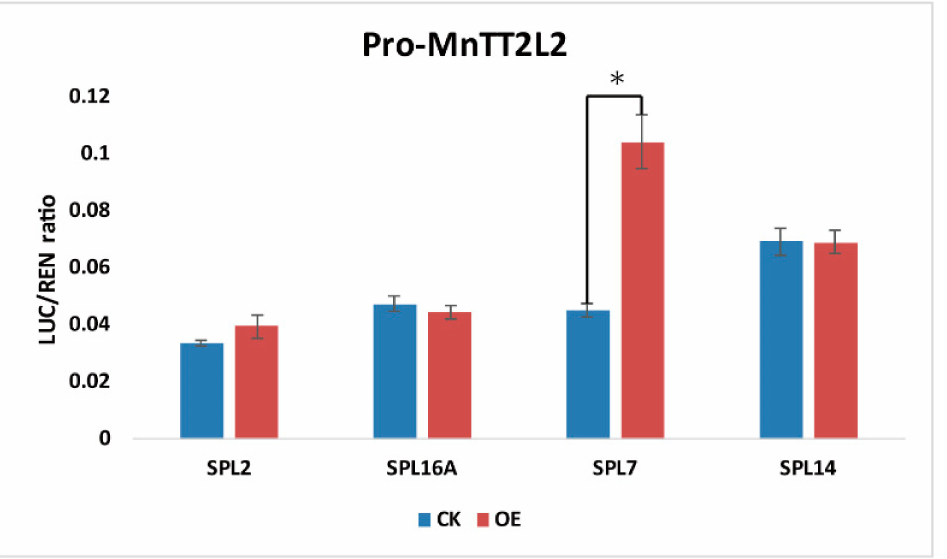
Figure 9. Dual-luciferase assays identified the interaction between SPL genes and the promoter of MnTT2L2 . CK: Control group. OE: overexpressed mulberry SPL genes. Values represent the mean ± SD of 3 biological replicates and were statistically analyzed (independent samples t -test): * p <